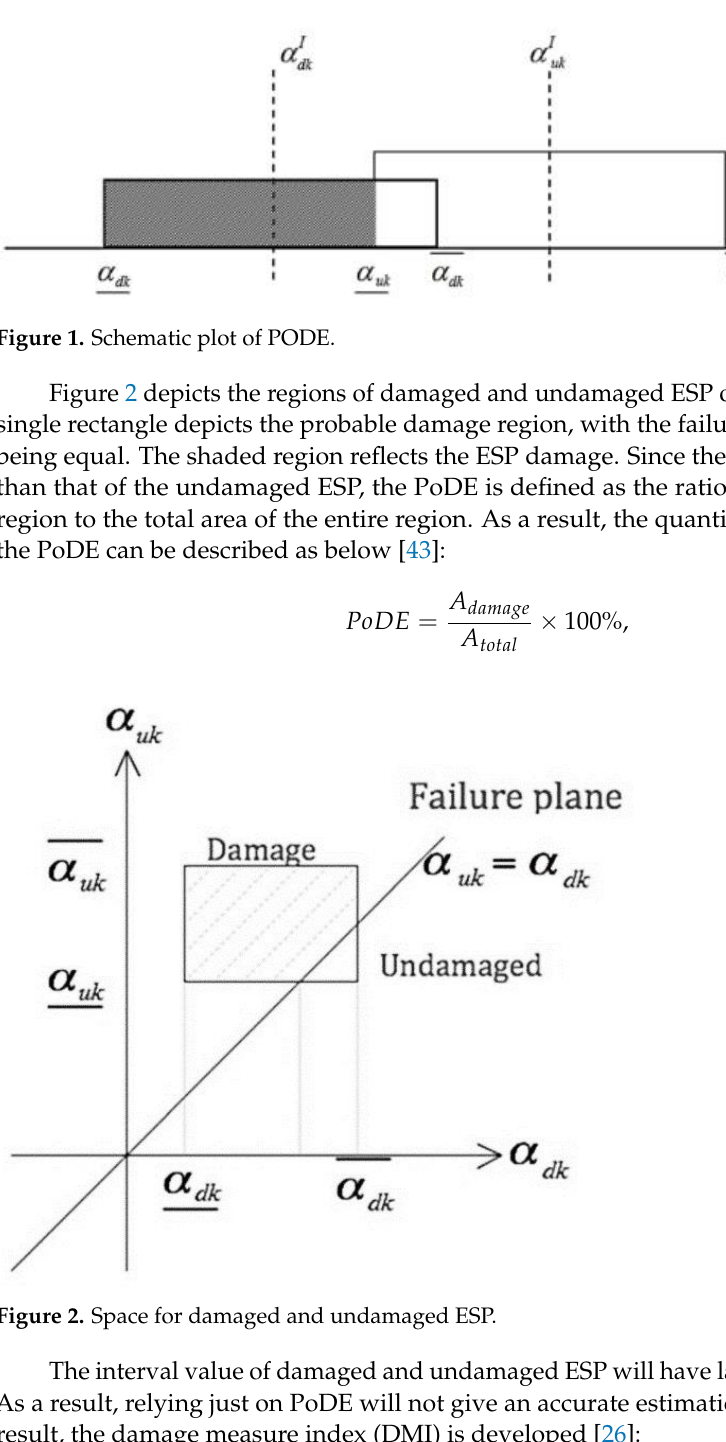
Figure 2. Space for damaged and undamaged ESP.